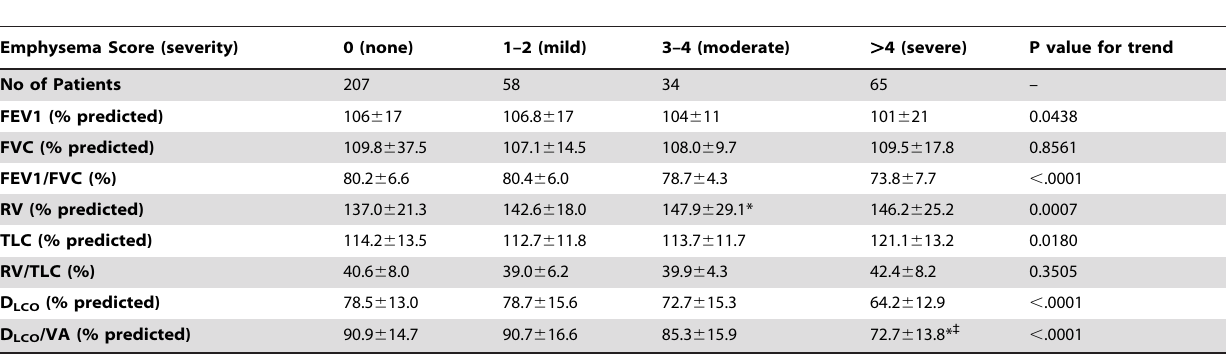
Table 4. Pulmonary Function Test Results Of 364 HIV Infected Subjects Stratified According To CT Based Emphysema